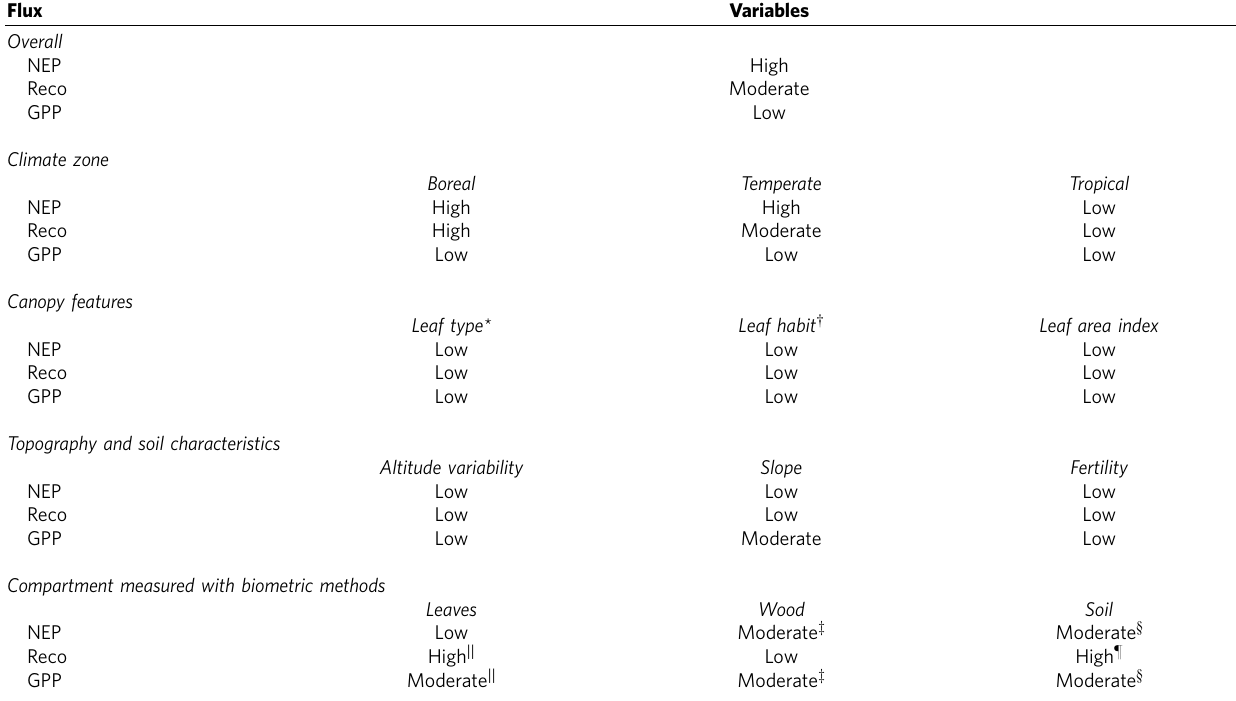
Table 4 | Risk of lack of convergence between estimates of forest carbon fluxes obtained from eddy-covariance and biometric methods according to site and methodological